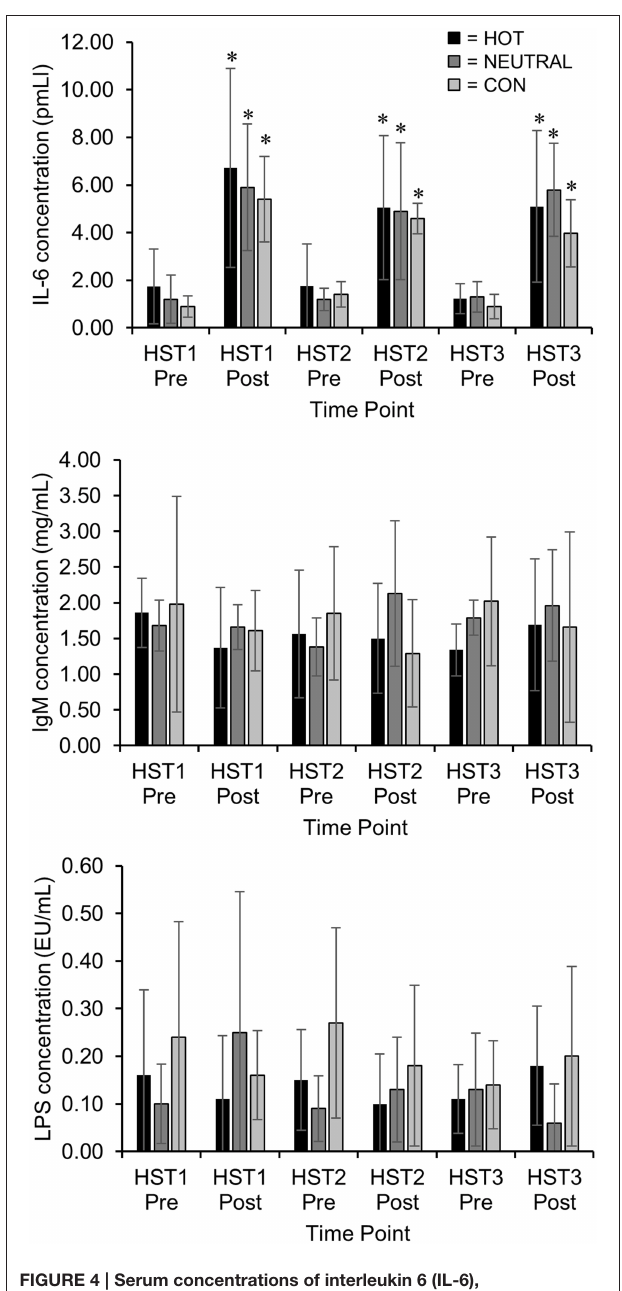
FIGURE 4 | Serum concentrations of interleukin 6 (IL-6), Immunoglobulin M (IgM), and Lipopolysaccharide pre and post Heat Stress Tests 1, 2, and 3. * Increased from pre exercise